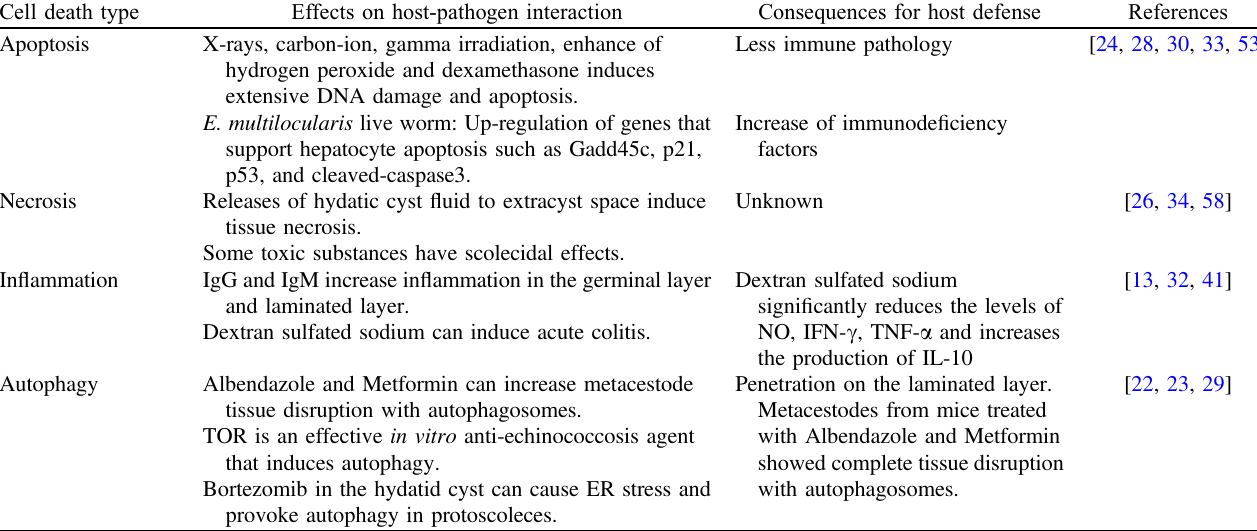
Table 1. Cell death and host defense in hydatid